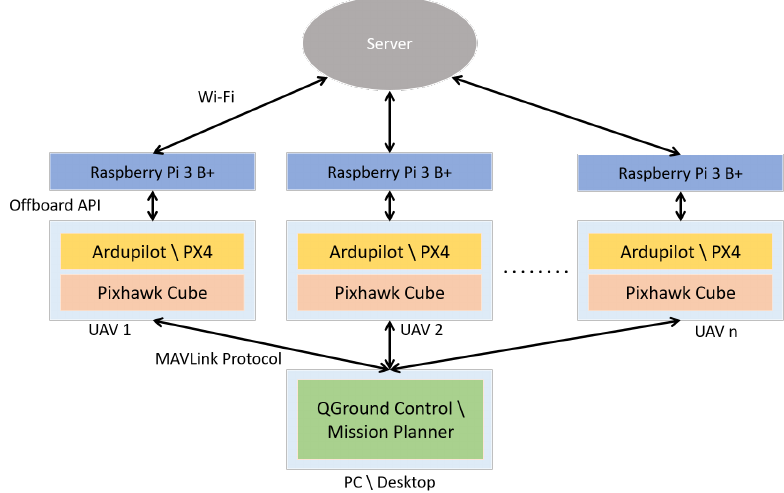
Figure 2. System architecture for Unmanned Aerial Vehicle (UAV) formation